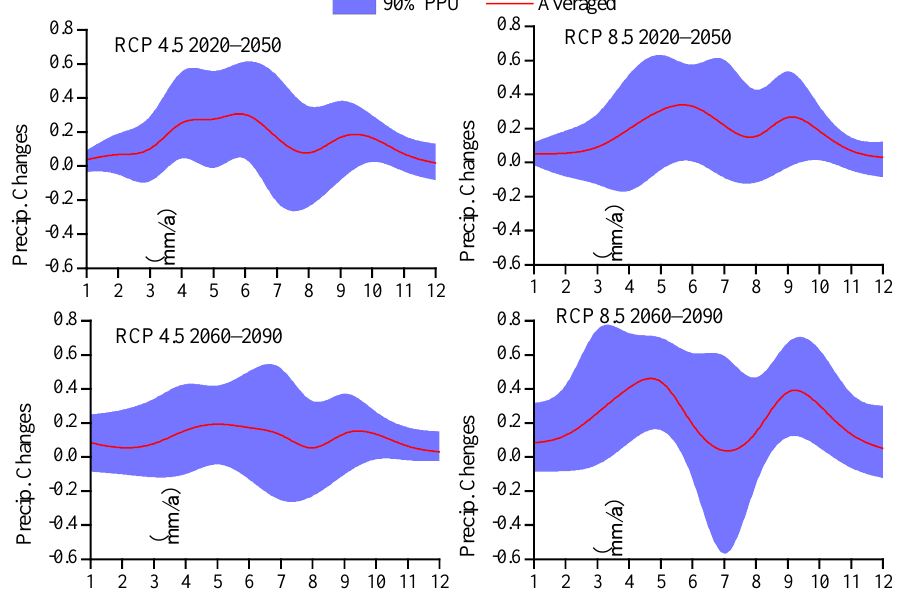
Figure 6. Future change tendency for the monthly precipitation in different periods and climate scenarios. The term “Precip.” represents precipitation. The red line shows the median; the borderline represents the 90% predictive uncertainty.